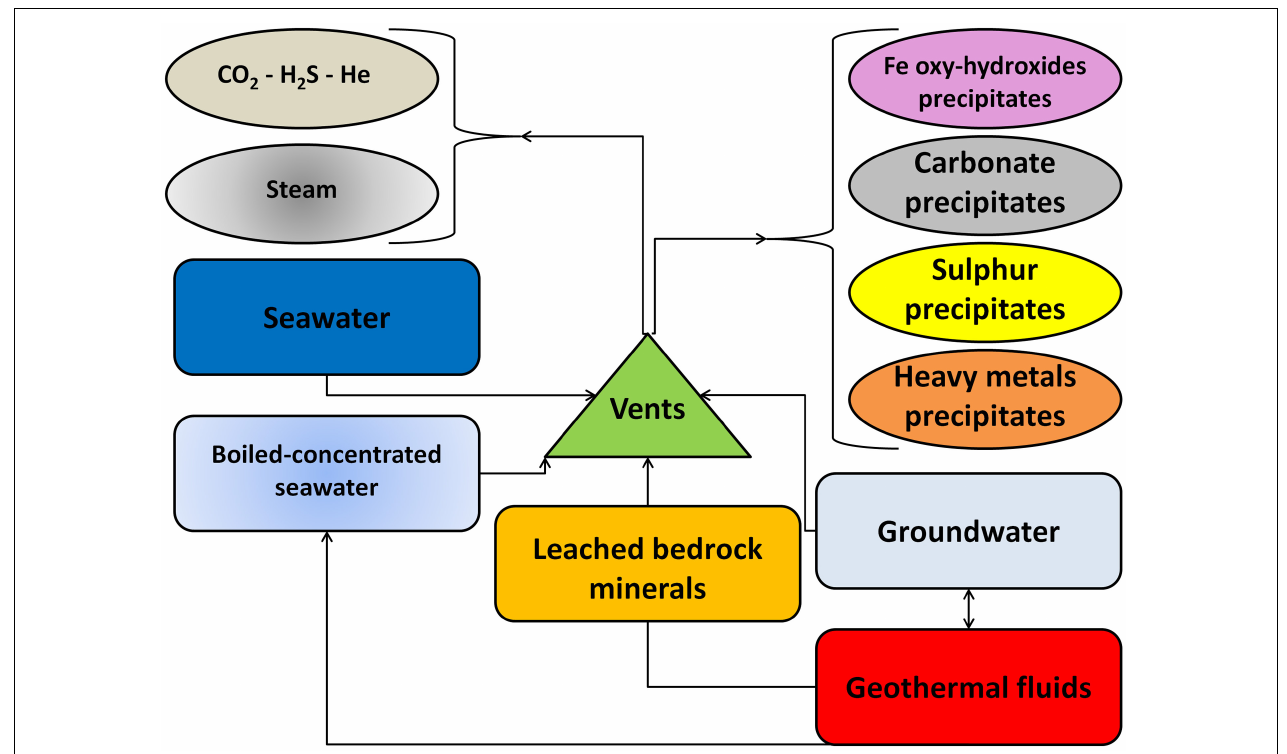
FIGURE 2 | General scheme of geothermal fluids interactions with bedrock, groundwater and